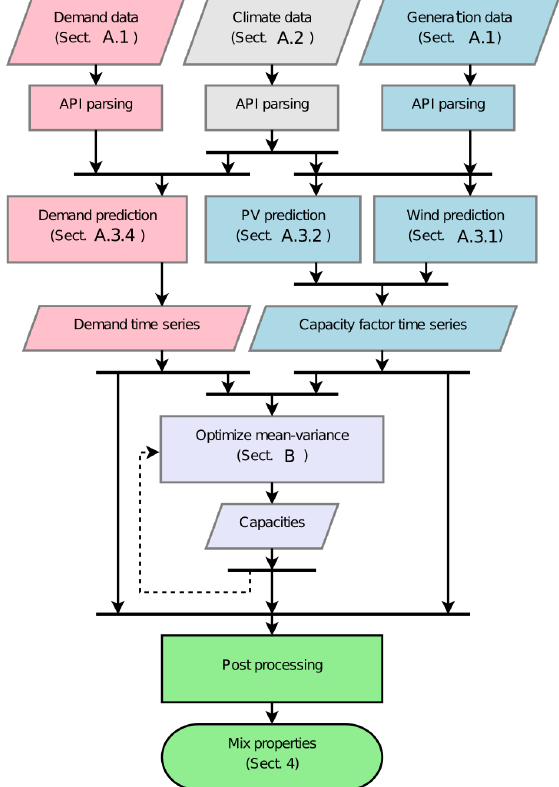
Figure 1. Flow chart of the concrete implementation of the mean-variance analysis for the Italian PV-wind